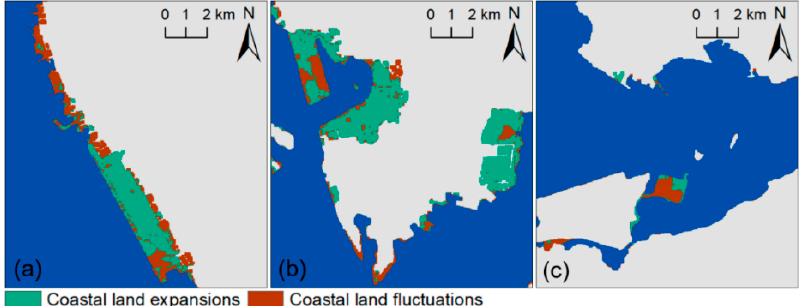
Figure 3. Coastal land expansions and fluctuations in three typical coastal areas in the study area. ( a ) West Coast of Bao’an District, Shenzhen; ( b ) Shekou Peninsula, Shenzhen; and ( c ) Chek Lap Kok, Hong Kong.